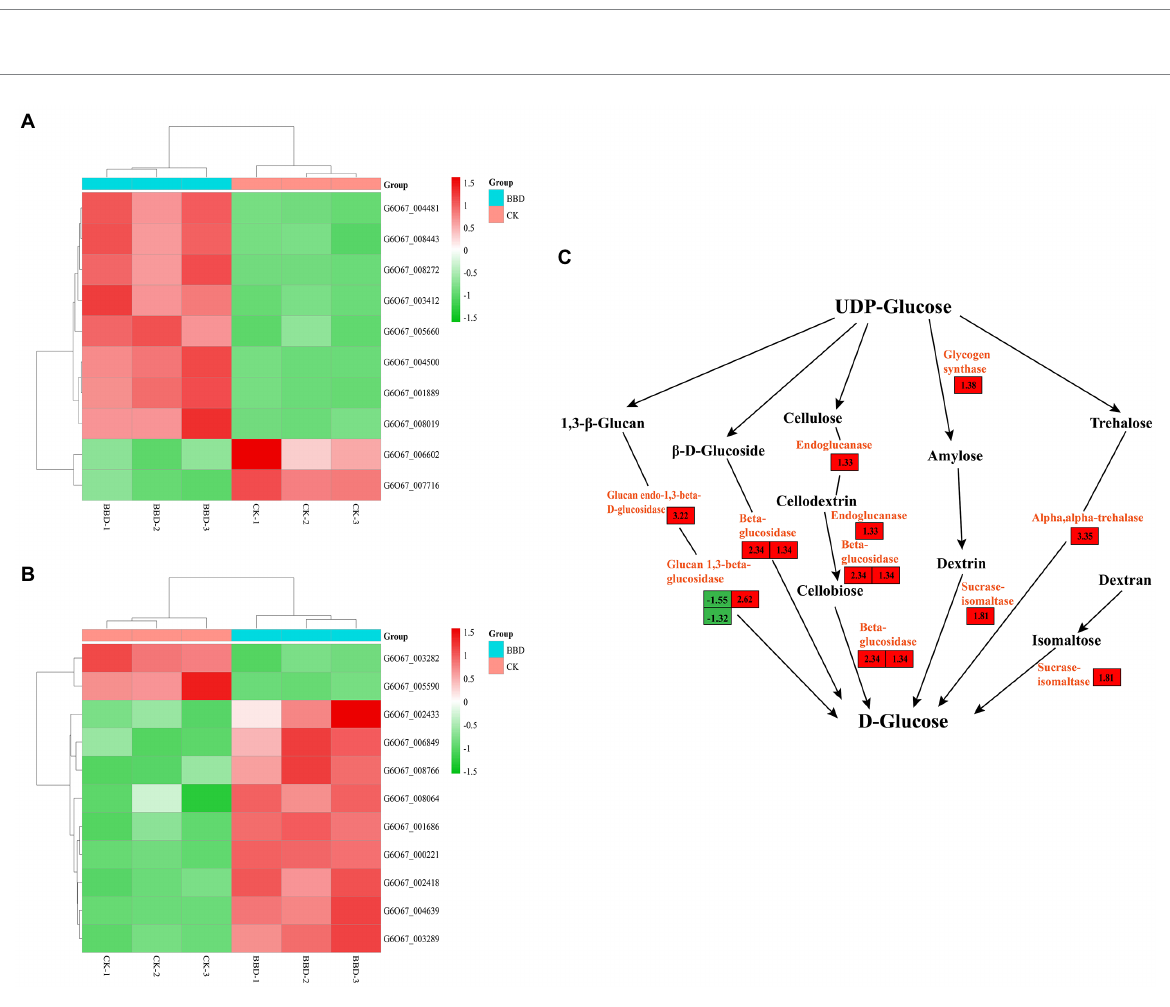
FIGURE 4 Based on KEGG analysis of differential genes in O. sinensis mycelium BBD and CK. Heatmaps illustrate the relative expression levels of these genes. (A) Tyrosine metabolism; (B) Starch and sucrose metabolism; (C) DEGs in starch and sucrose